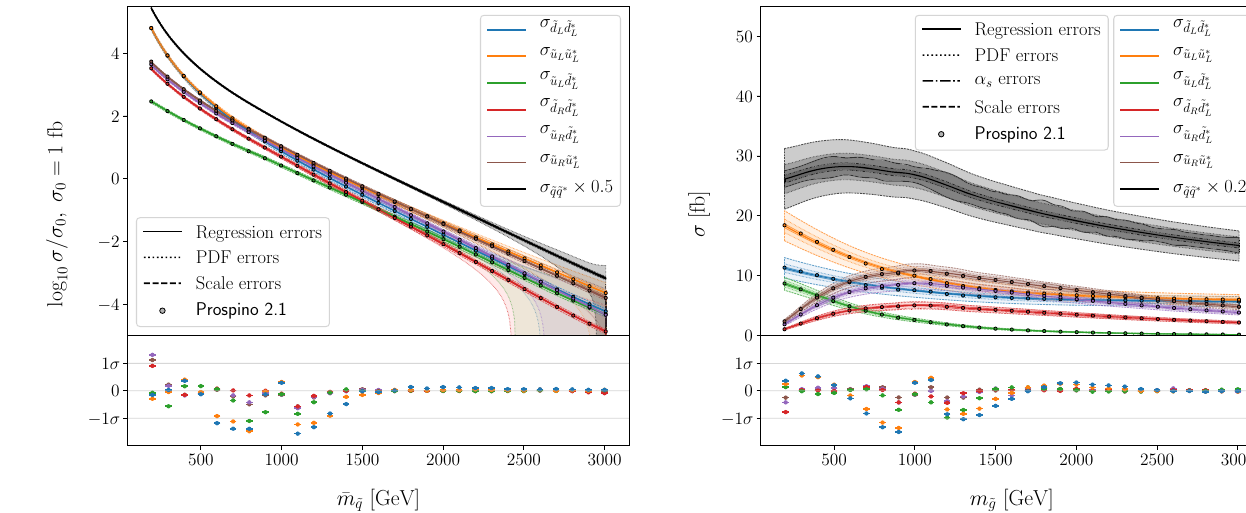
(left) and gluino mass (right), for a selection of final states (colours) and the total cross-section for production of first and second-generation squark–anti-squark pairs